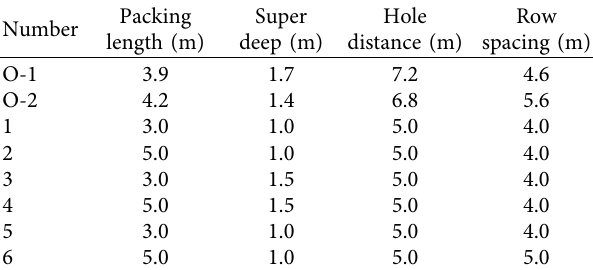
Table 4: Blasting scheme.